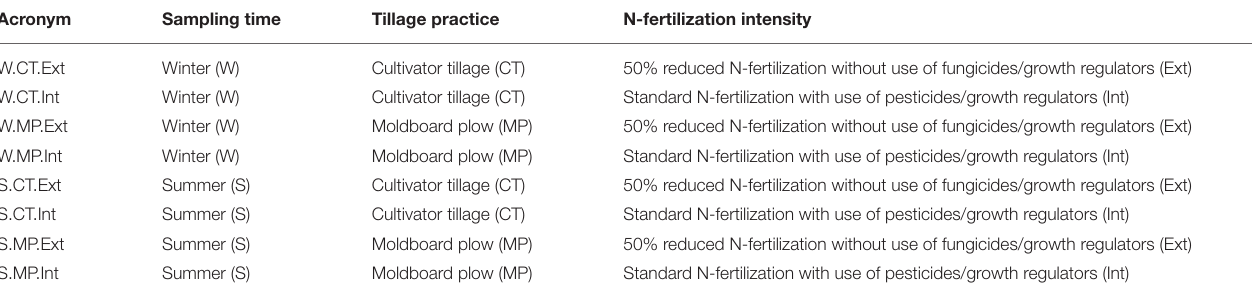
TABLE 1 | Overview of long-term agricultural practices (treatments; n = 4 replicates) studied at LTE Bernburg.